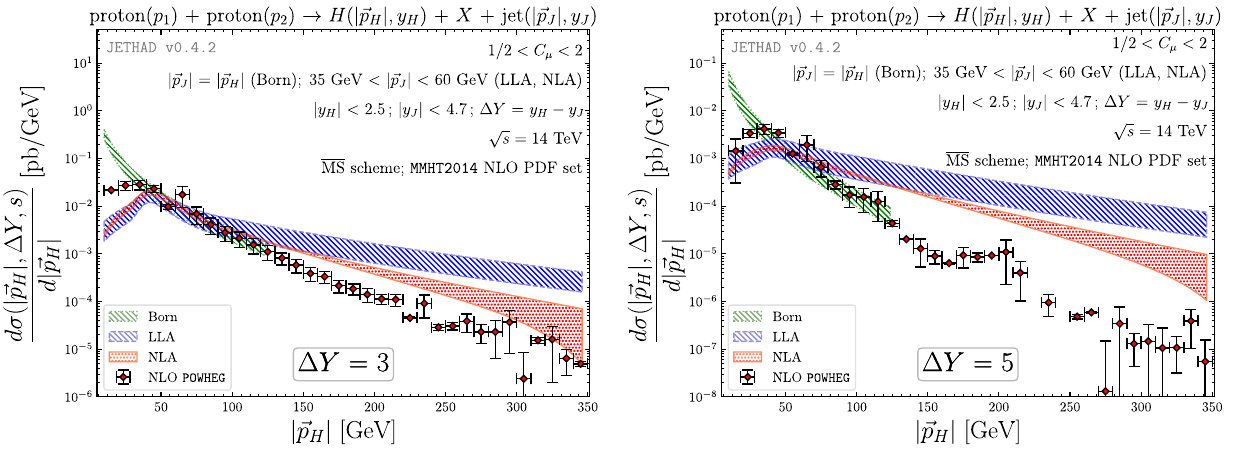
√ s = 14 TeV and for